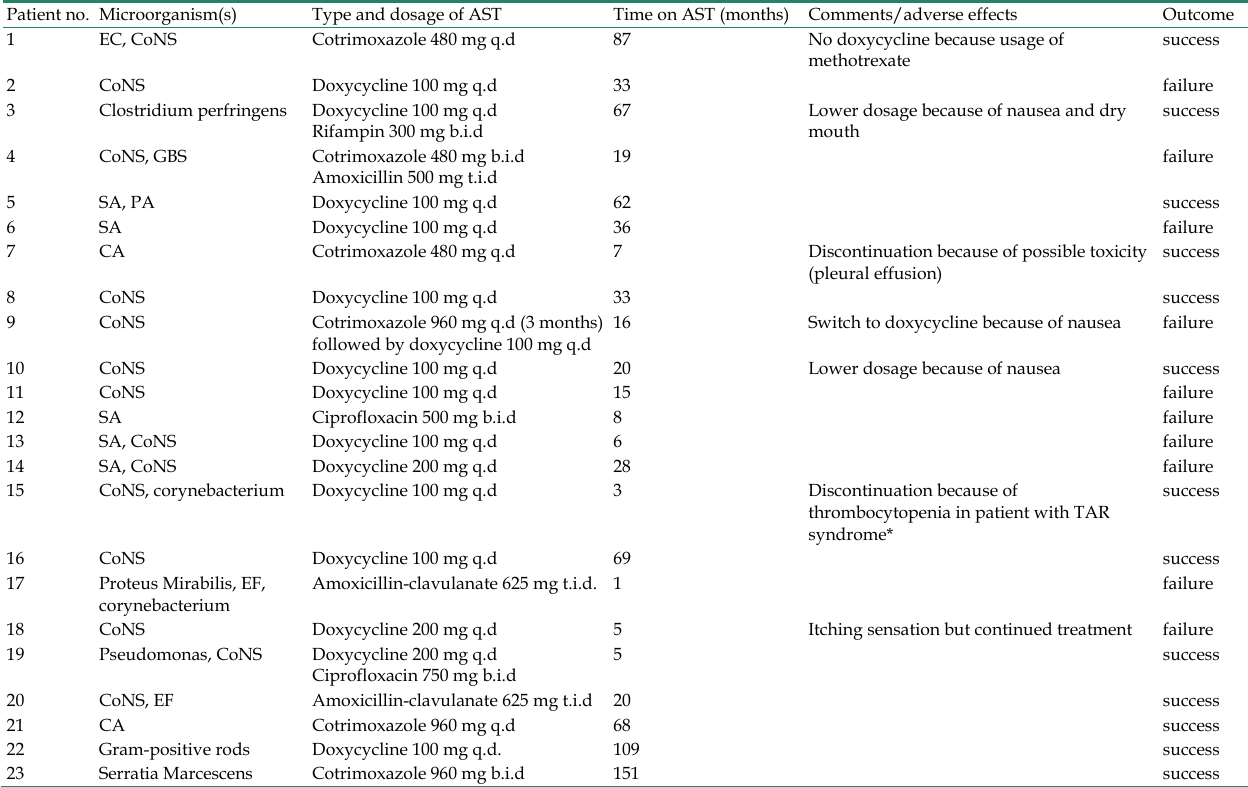
Table 2. Identified microorganisms and agents, dosages and duration of the used antibiotic suppressive therapy Patient no. Microorganism(s)